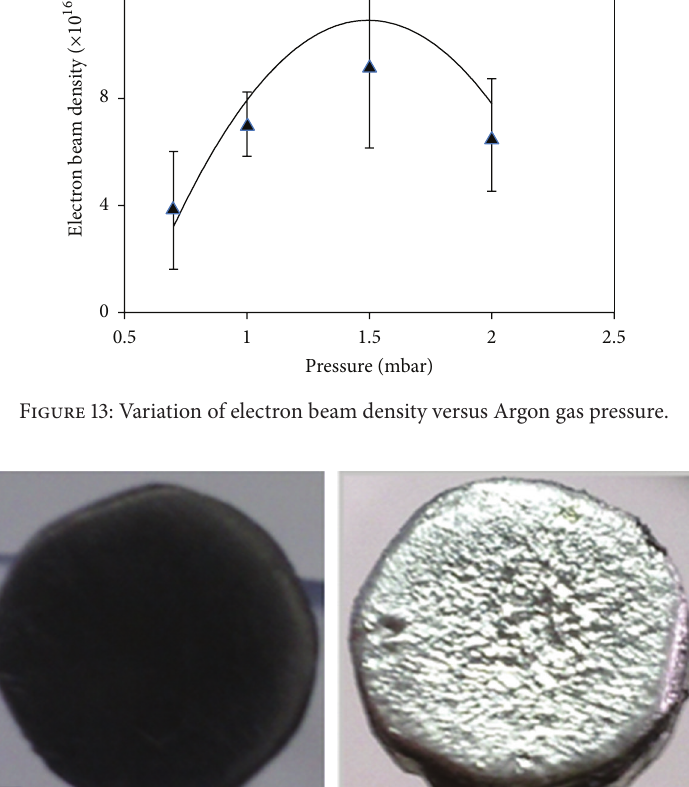
because of the strong bombardment of the electron